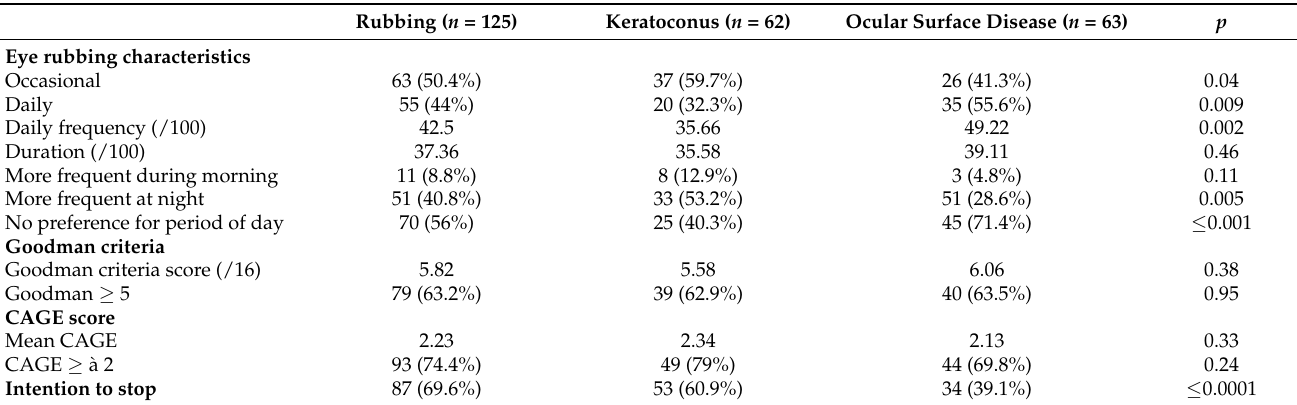
Table 3. Cognitive–behavioral characteristics of eye